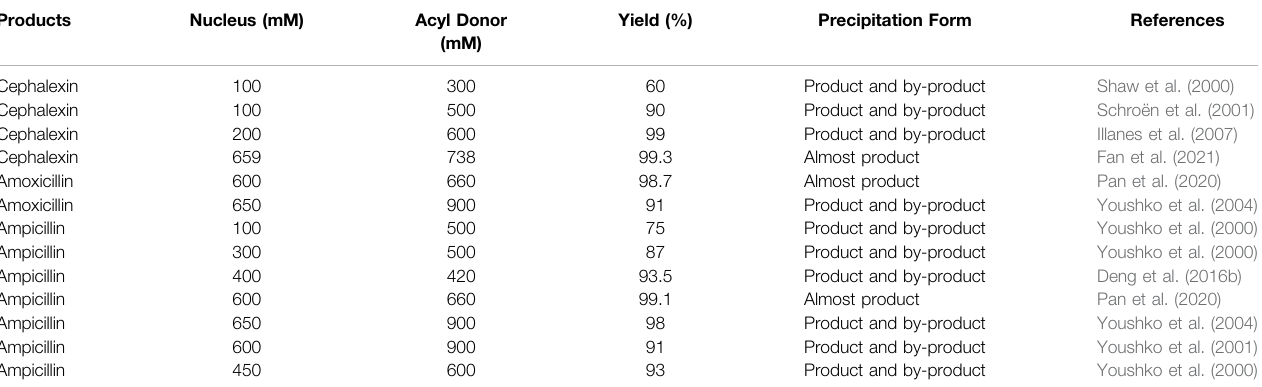
TABLE 5 | Synthesis of β -lactam antibiotics by PGA using high substrate concentration.